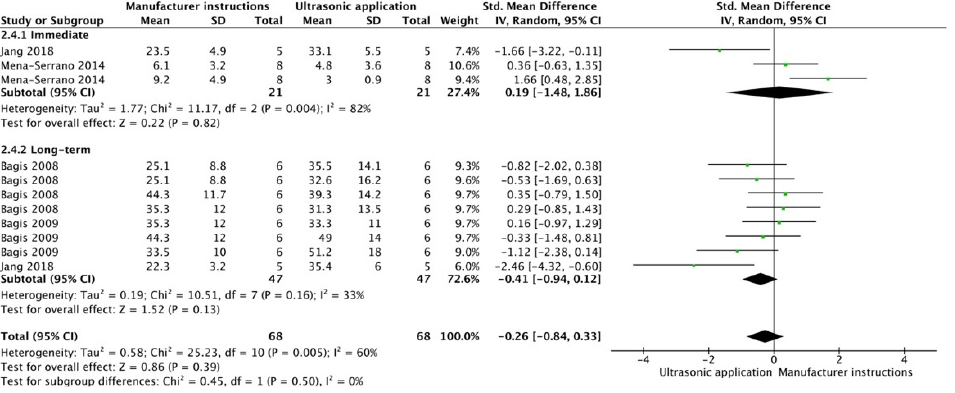
Figure 13. Forest plot showing the bond strength values when the adhesive was applied with an ultrasonic device.